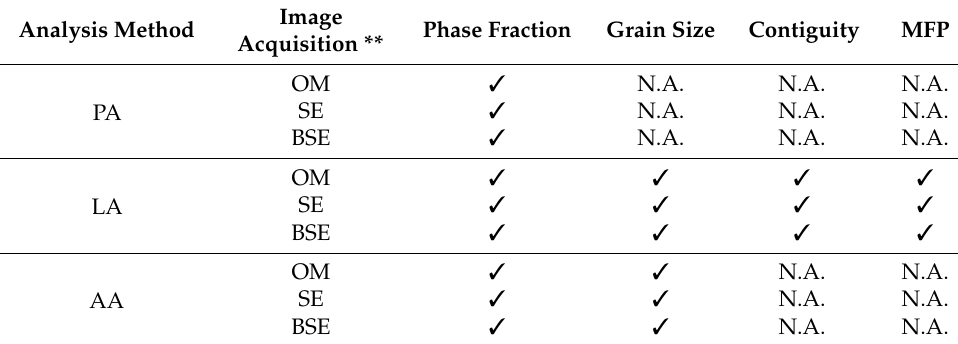
Table 5. Details of the complete measurement program *. Image Phase Fraction Grain Analysis Method Acquisition **